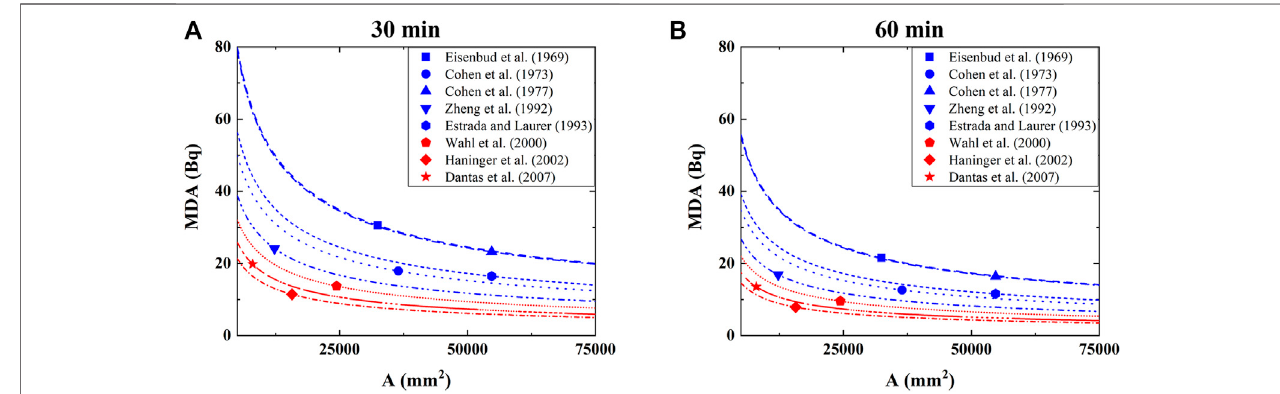
Frontiers in Energy Research |